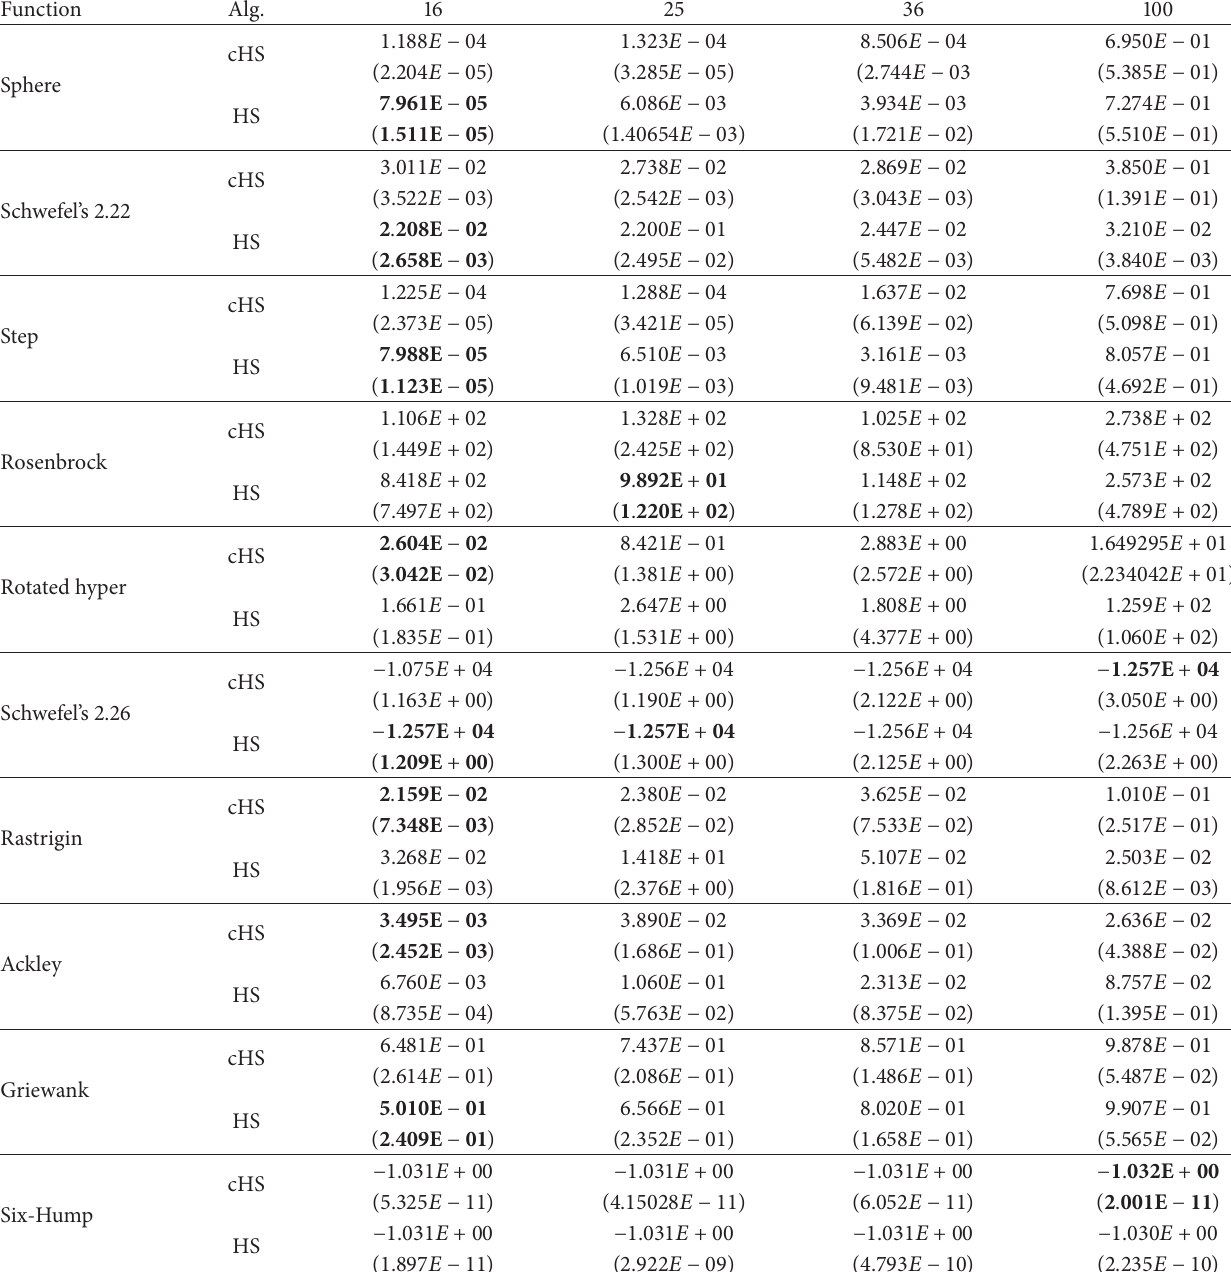
Table 5: The effect of varying the HMS parameter on HS and cHS for ten functions ( 𝑓 1 – 𝑓 10 ). Function